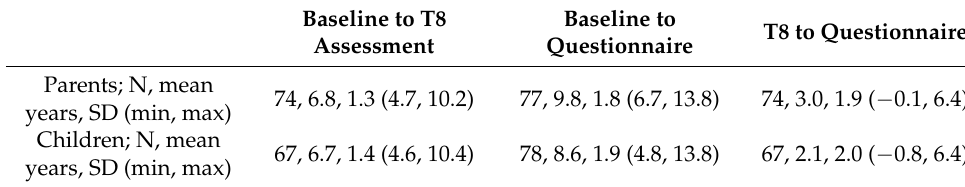
Table 2. Time to semi-structured interview.